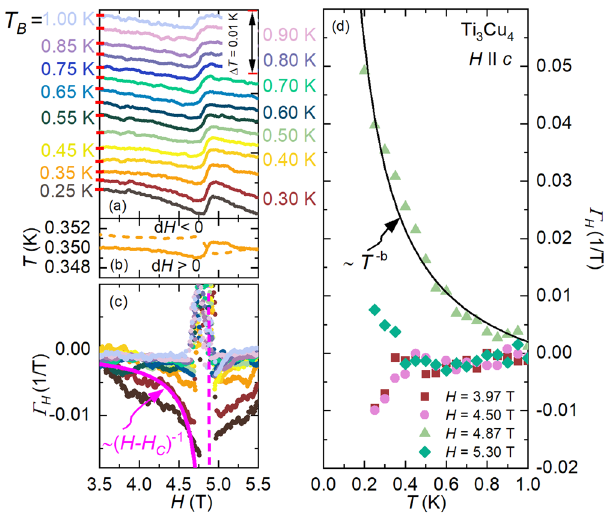
Fig. 7 Divergence of the Grüneisen ratio at the critical fi eld. a Magneto- caloric effect (MCE) measurements for magnetic fi elds H ∥ c and d H > 0 measured at various bath temperatures T B . Data are offset by arbitrary values for clarity, where the red lines indicated a zero change in temperature Δ T , and the scale bar on the right gives the absolute change in temperature. b A zoom in of the T B = 0.35 K MCE data measured with d H > 0 (solid line) and d H < 0 (dashed line). c The fi eld-dependent Δ T ¼ 1 magnetic Grüneisen ratio ( Γ Δ H ) diverges as H approaches the H T B critical fi eld H C . The pink solid line is a guide to the eye and is proportional to 1 , while the vertical pink dashed line denotes H C . d The temperature H (cid:2) H c dependence of the magnetic Grüneisen ratio at selected fi elds below H C (red squares and pink circles), at H C (light green triangles), and above H C (dark green diamonds). At H = H C , the magnetic Grüneisen ratio diverges as T − b (solid black